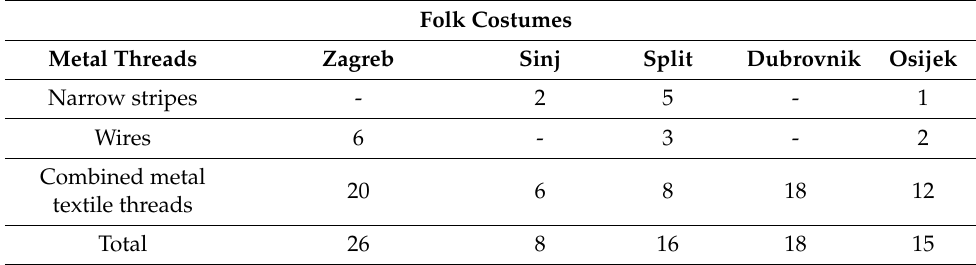
Table 2. Table of all metal thread samples from folk